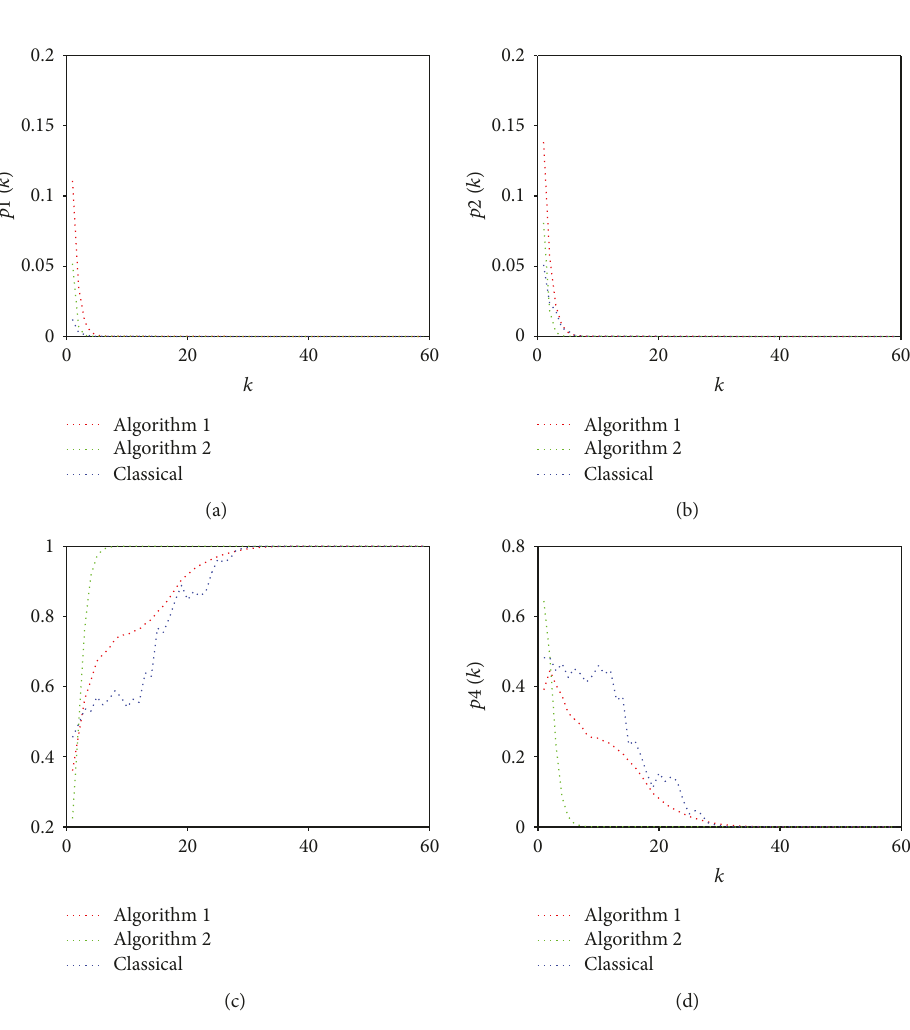
Figure 2: The weight signals of three weighting algorithms in Case